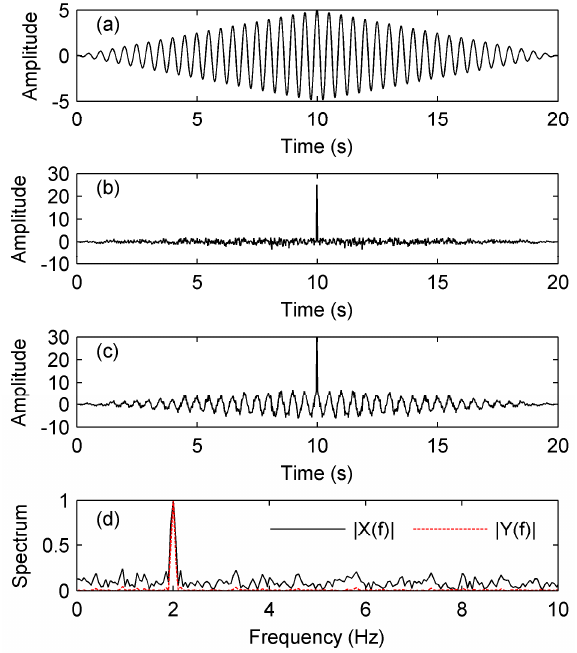
Figure 7. Simulation results of the TRC-IS when the SNR = − 10 dB. ( a ) time reversal convolution (TRC) of the signal s ( t ); ( b ) TRC of the noise n ( t ); ( c ) TRC of the signal contaminated by noise x ( t ); ( d ) Normalized spectrum with and without TRC-IS.